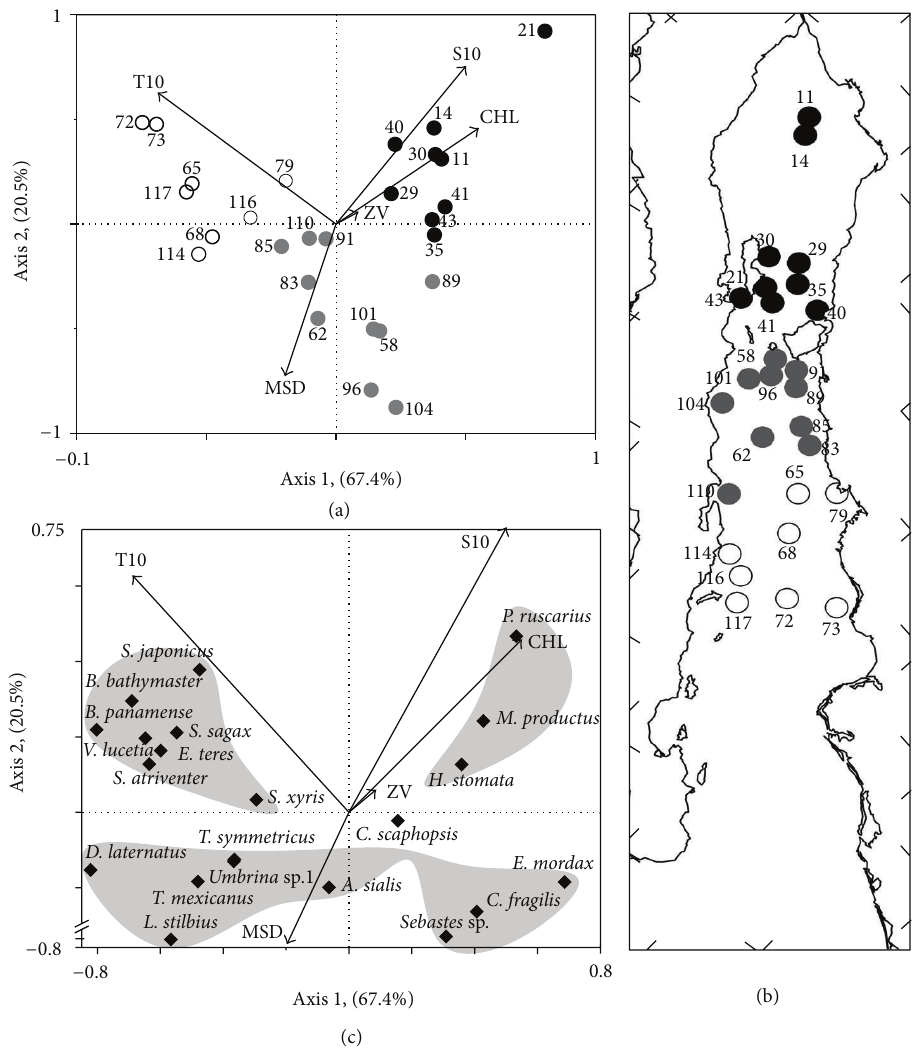
Figure 6: Classification and ordination analysis: January. (a) RDA biplot of sampling stations environment, black circles = JaG1; grey circles = JaG2; open circles = JaG3. (b) Distribution of stations groups resulting from RDA. (c) RDA biplot species environment.